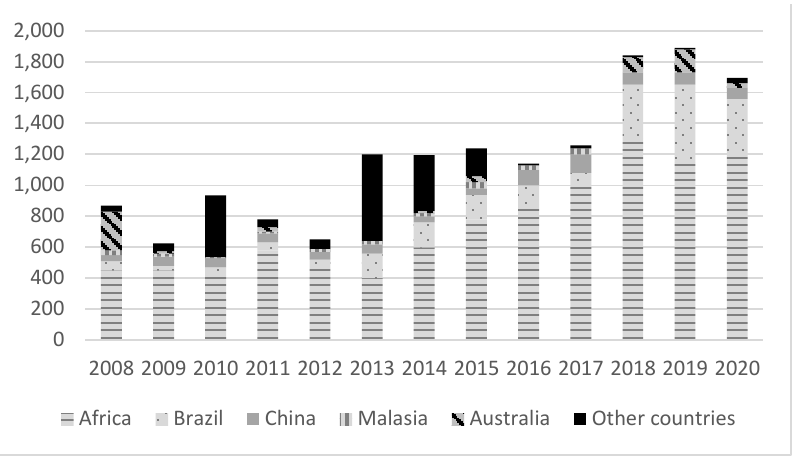
Figure 2. Historical production of tantalum in metric tons, adapted from [23].